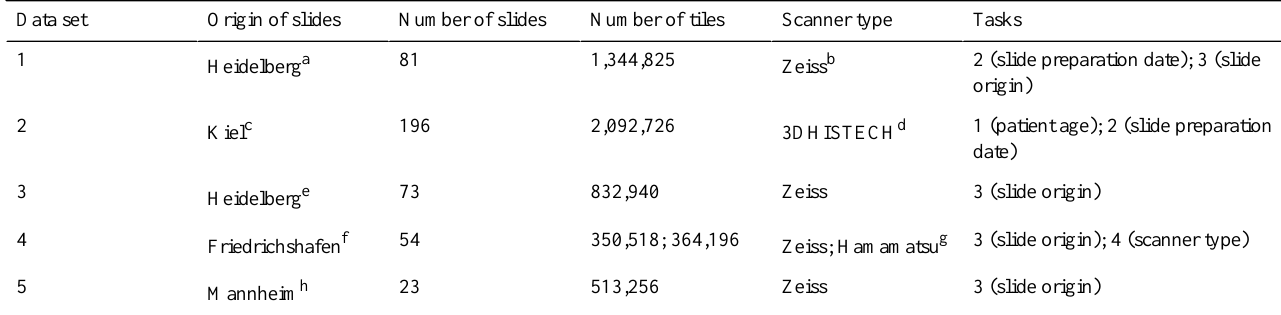
Table 1. Overview of individual data